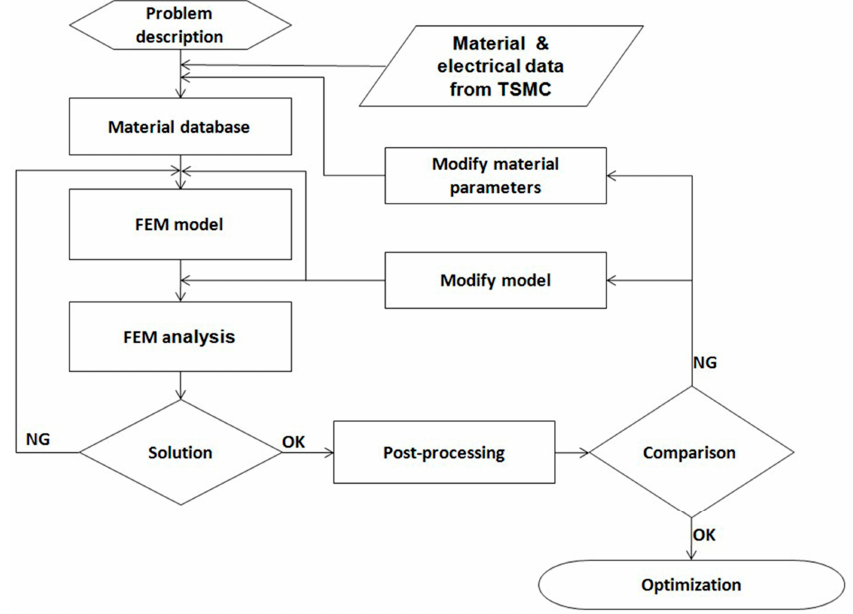
Figure 7. Flowchart of the simulation process. Table 4. Leakage current data measured by Taiwan Semiconductor Manufacturing Co., Ltd.